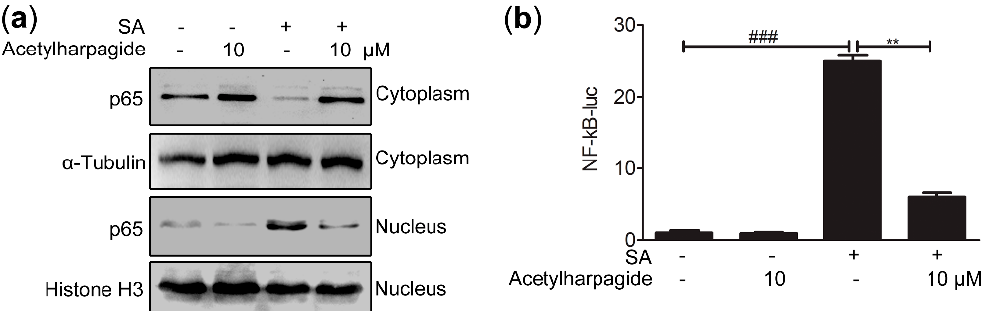
Figure 6. Acetylharpagide suppressed S. aureus (SA)-induced NF- κ B activity. ( a ) Raw264.7 cells were pretreated with acetylharpagide or DMSO for 2 h, then stimulated with S. aureus (multiplicity of infection (MOI), 10:1) for 2 h. Nuclear and cytoplasmic proteins were extracted and detected for the expression of p65 by western blot; ( b ) NF- κ B luciferase reporter plasmid was transfected into Raw264.7 cells. After 24 h, cells were stimulated as in A. Luciferase assays were carried out with the was evaluated to reflect NF- κ B activity. The relative luciferase activity normalized to the control group is shown. The data were presented as mean ± SD, ### p < 0.001 vs. PBS+DMSO group, ** p < 0.01 vs. SA+DMSO group, n = 3.